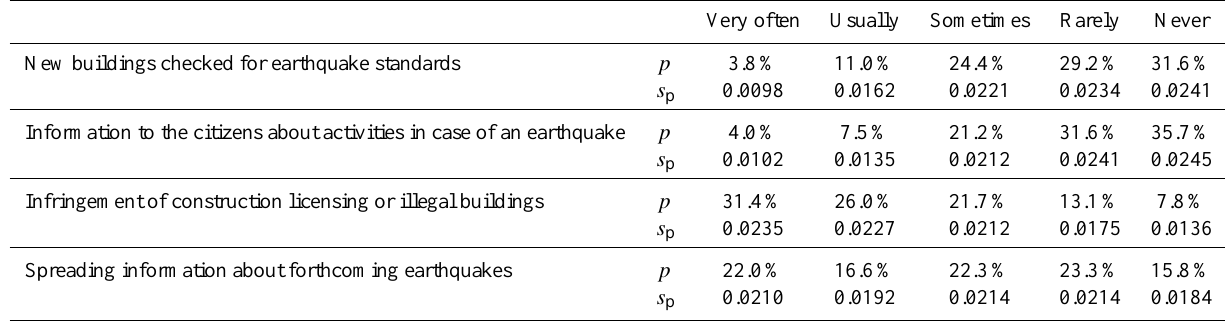
Table 6. Residents’ opinions about the activities that take place in the Sporades islands regarding earthquakes consequences. Very often Usually Sometimes Rarely Never New buildings checked for earthquake